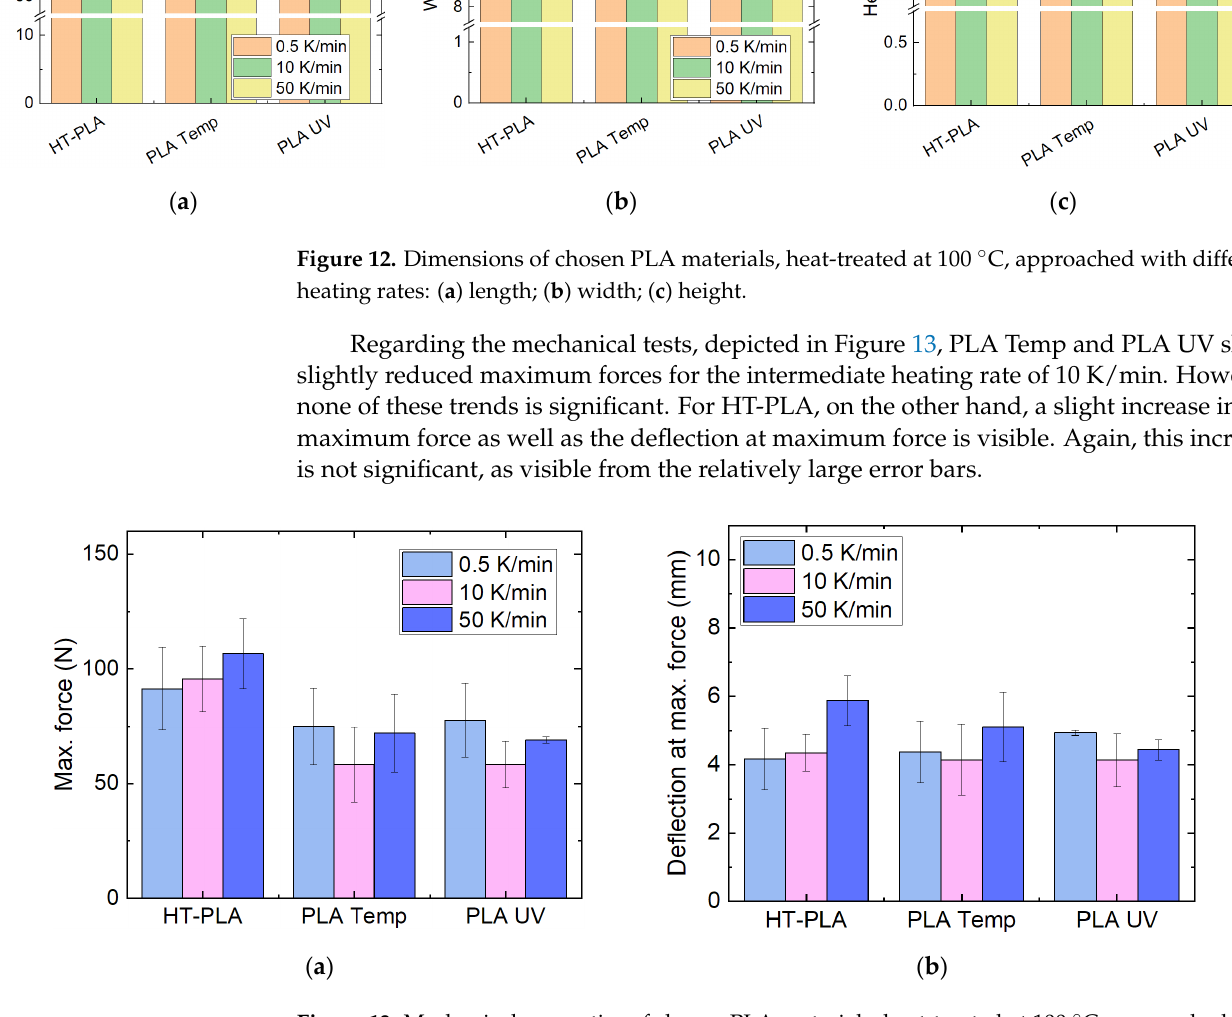
Figure 12. Dimensions of chosen PLA materials, heat-treated at 100 °C, approached with different heating rates: ( a ) length; ( b ) width; ( c ) height.